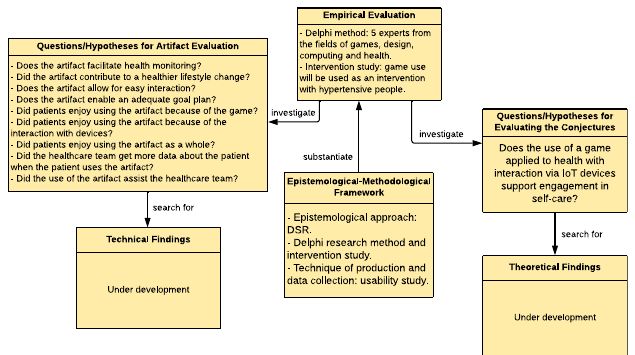
Figure 6. Artifact evaluation questions, empirical evaluation, hypotheses for conjecture evaluation, epistemological-methodological framework, and